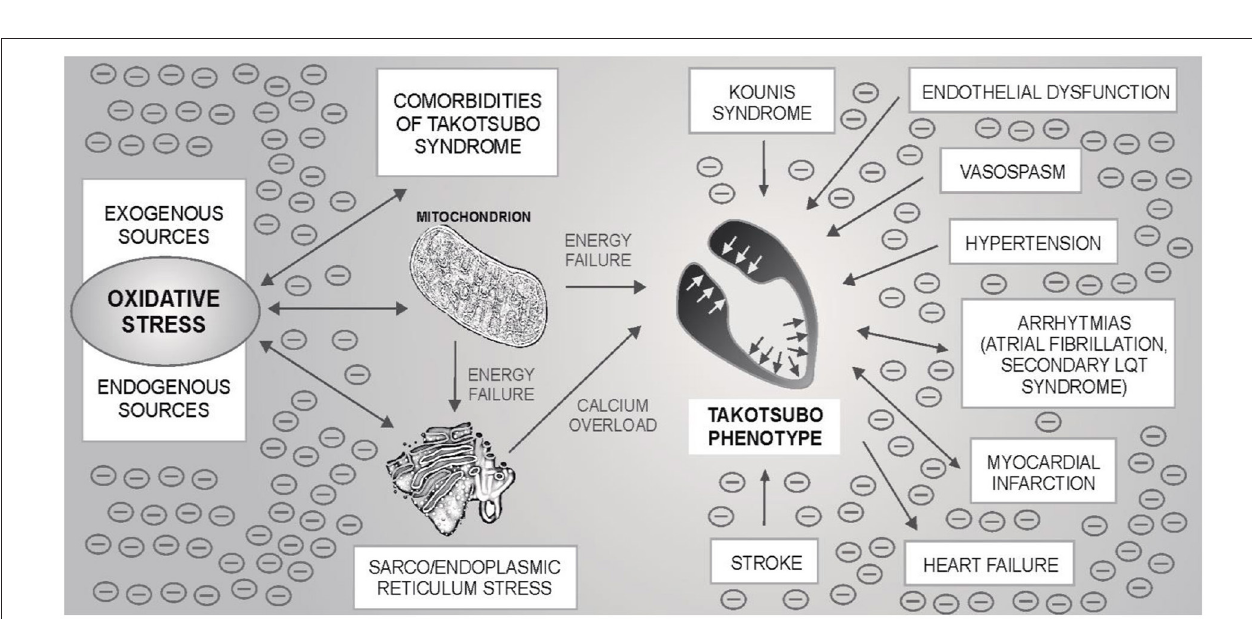
FIGURE 2 | Possible relationship between oxidative stress (OS), mitochondria-sarco/endoplasmic reticulum complex, Takotsubo syndrome (TTS) and other cardiovascular pathologies. By the mechanisms described in the text, OS can lead to the blockade of energy production and calcium overload of myocytes with the subsequent development of an acute attack of TTS. OS is also associated with some TTS comorbidities - one of the most common is hypertension, but also e.g., atrial fibrillation. Secondary long QT syndrome and/or heart failure may be present in TTS. Stroke (ischemic or hemorrhagic) and, exceptionally, myocardial infarction have been described as the triggers of an acute TTS attack. If TTS is associated with OS, an acute attack itself can be an important source of OS. The oxidation load is likely to be potentiated. OS may affect other cardiac structures, incl. coronary (micro) circulation or cardiac conduction system. Endothelial dysfunction and vasospasm have previously been mentioned as possible pathophysiological mechanisms in TTS. Under these circumstances, an acute TTS attack could trigger an acute myocardial infarction. Kounis syndrome is an “allergic” acute coronary syndrome caused by allergic, hypersensitivity, anaphylactic or anaphylactoid conditions. There are three types of the disease: caused by a coronary artery spasm, by the acceleration of the pre-existing atherosclerotic changes in the coronary arteries, and by hypersensitivity reactions to the coronary stent material leading to “in stent” thrombosis, respectively.